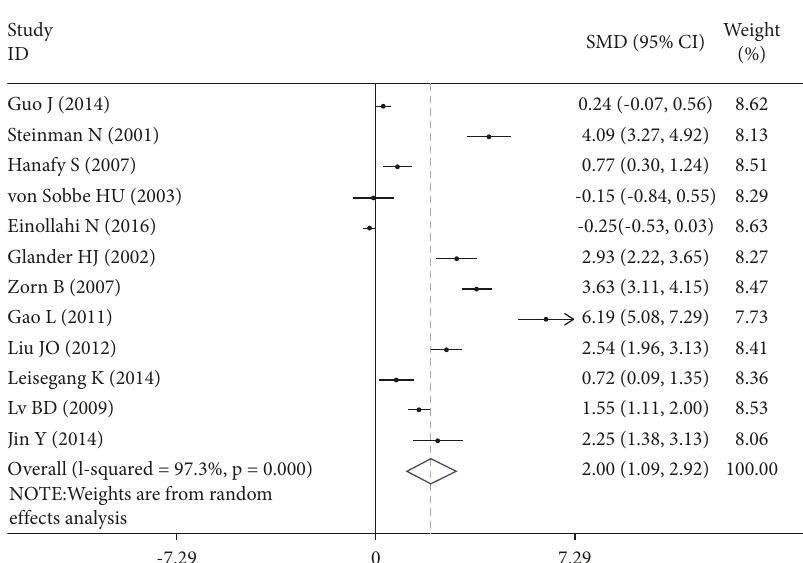
Figure 2: The SMD of leptin concentration in serum and male infertility risk. SMD: standardized mean difference. Note: weights are from the random-effects analysis.